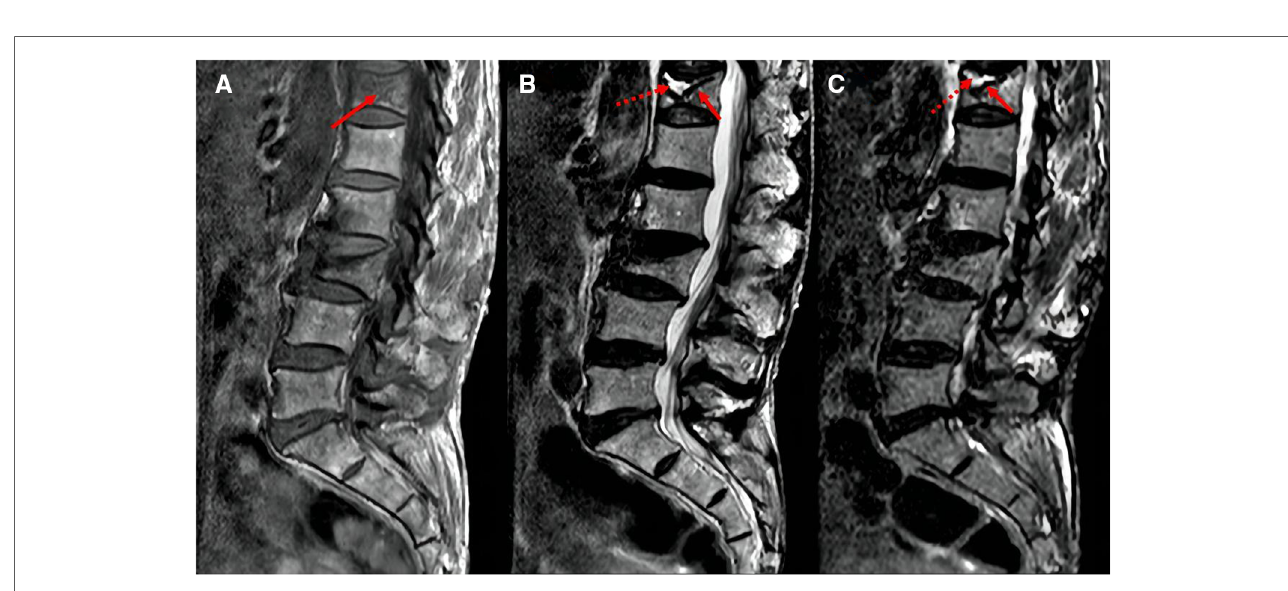
FIGURE 3 MRI images of intravertebral vacuum cleft. Hypointense on T1-weighted images ( A , arrows); hyperintensity or hypointensity on T2-weighted images ( B ) or STIR images ( C ), depending on fl uid (dotted arrows) or gas (solid arrows) fi